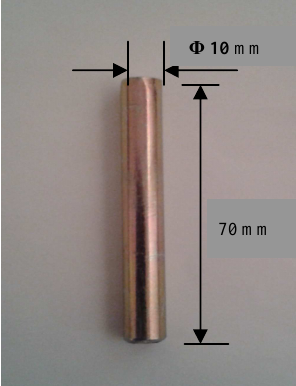
Fig. 1. Tool used in experimental work.